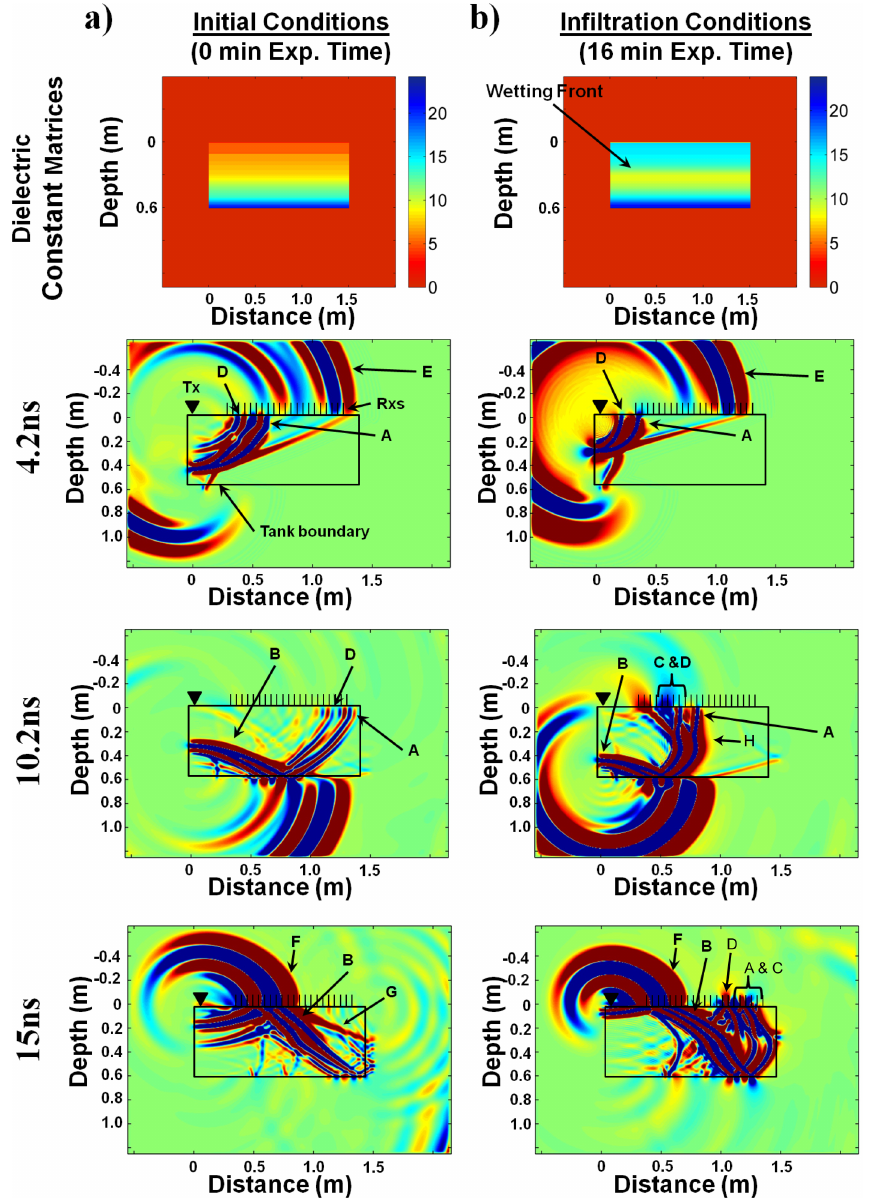
Fig. 8. Propagation of radar waves during iterations of the 2-D radar model showing evolution of radar wavefield through time. Visible arrivals are the groundwave (A), bottom of sand reflection (B), wetting front reflection (C), side of tank reflection (D), airwave (E), air- refracted bottom of tank reflection (F), bottom of sand refraction (G), and wetting front refraction